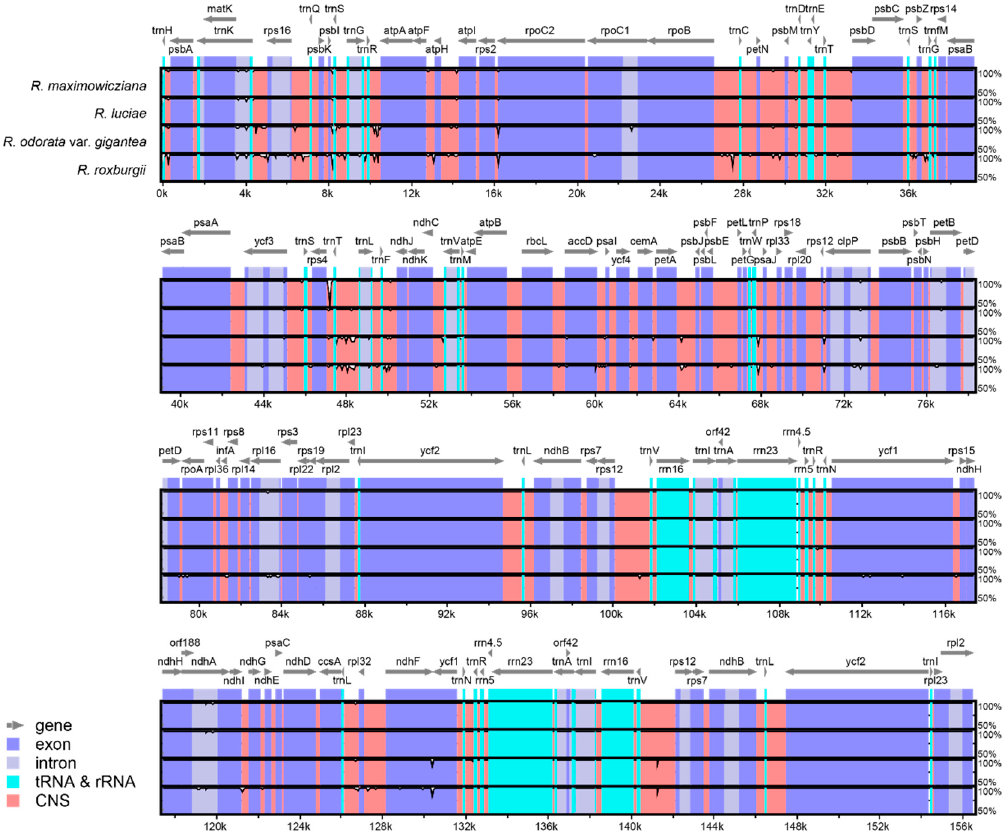
Figure 5. Visualized alignment of the Rosa chloroplast genome sequences with annotations, using mVISTA. Each horizontal lane shows the graph for the sequence pairwise identity with a R. multiflora chloroplast genome sequence. The x-axis represents the base sequence of the alignment and the y-axis represents the pairwise percent identity within 50–100%. Grey arrows represent the genes and their orientations. Blue boxes represent exon regions and light gray boxes represent intron regions; light blue boxes represent RNA-coding gene regions; red boxes represent non-coding sequence (CNS) regions.